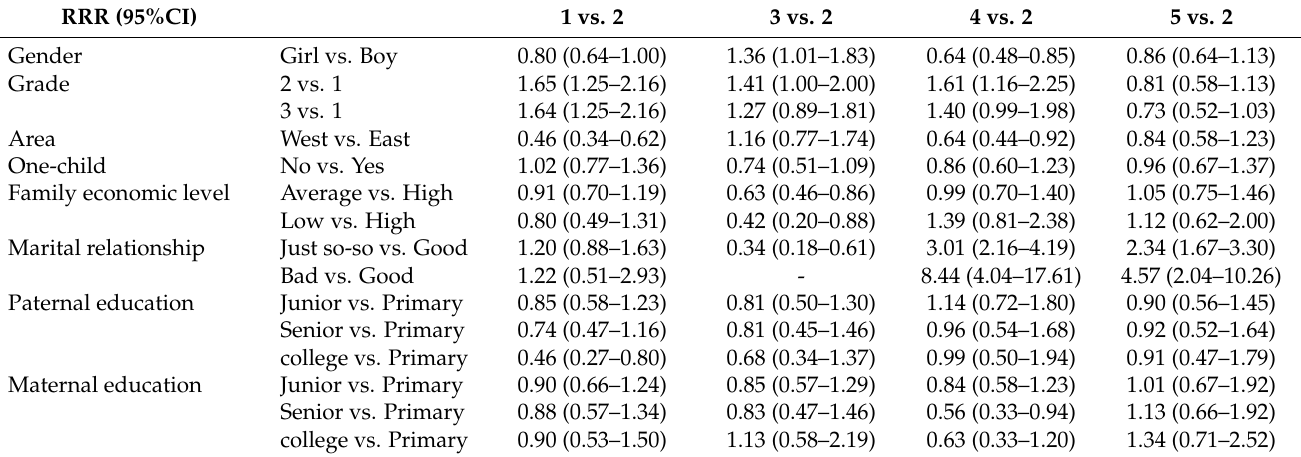
Table 5. Covariate predictors of latent class membership (compared with class 2 monitoring